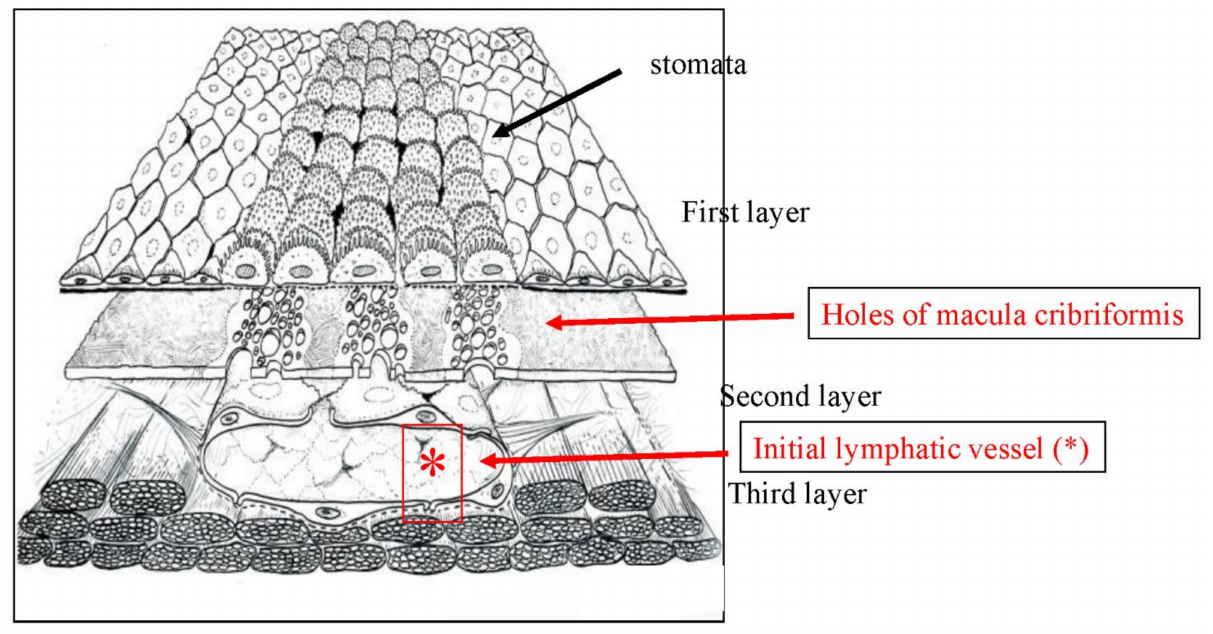
Figure 6. Schematic showing the triplet structure of the peritoneum in Morrison’s pouch, the para- colic gutter, and the pelvic peritoneum. The first layer is the mesothelial cells and basement membrane. The second layer is a sieve-like collagen plate named macula cribriformis (MC). The third layer is initial lymphatic vessels (*) attached to holes of